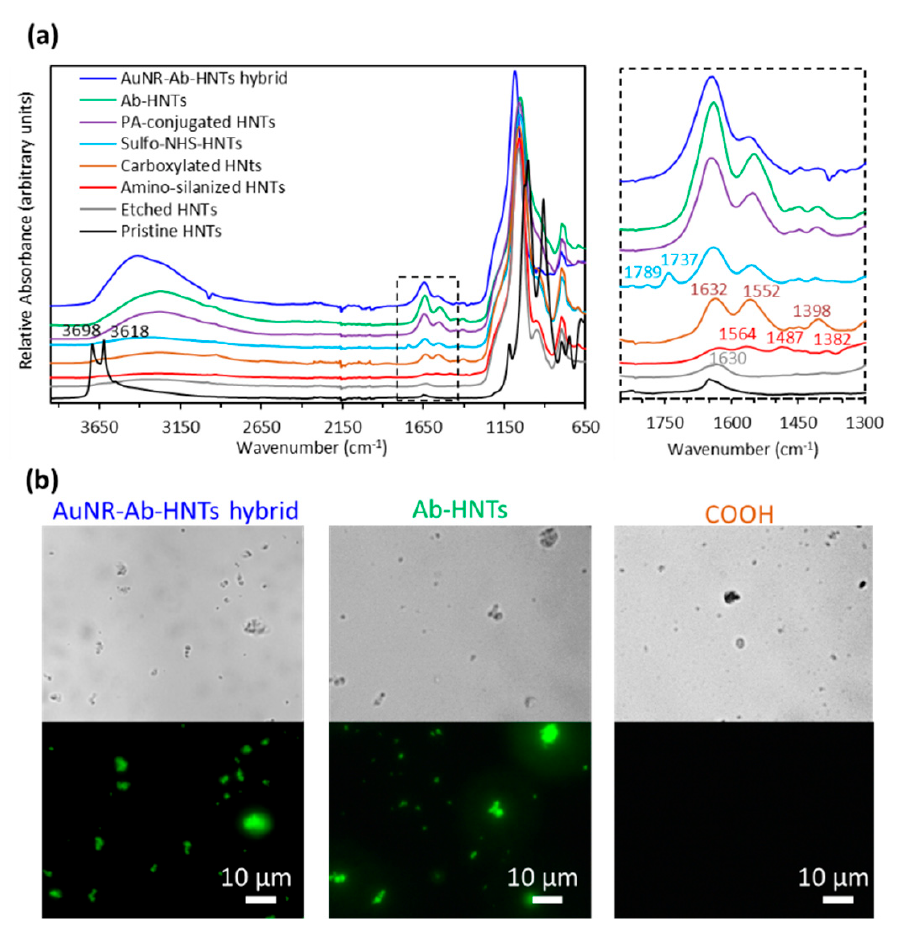
Figure 1. Anti -E. coli antibody immobilization onto HNTs and AuNR-Ab-HNTs hybrids. ( a ) FTIR- ATR spectra at the wavenumber range of 4000–650 cm − 1 (left panel), and a zoom-in view at 1850–1300 cm − 1 (right panel) for the various synthetic steps: Pristine HNTs (black), Etched HNTs (grey), Amino-silanized HNTs (red), Carboxylated HNTs (brown), Sulfo-NHS-activated HNTs (light blue), PA-conjugated HNTs (purple), Antibody-functionalized HNTs (green), and AuNR-Ab-HNTs hybrids (blue). All spectra are normalized to the inert highest peak in the spectrum. ( b ) Immunolabel- ing with FITC-anti-rabbit antibody for AuNR-Ab-HNTs hybrids (left panel), antibody-functionalized HNTs before AuNR incorporation (middle panel), and carboxylated HNTs (right panel). Upper panels depict bright-field microscopy images, and the bottom panels show the corresponding green fluorescence micrographs.